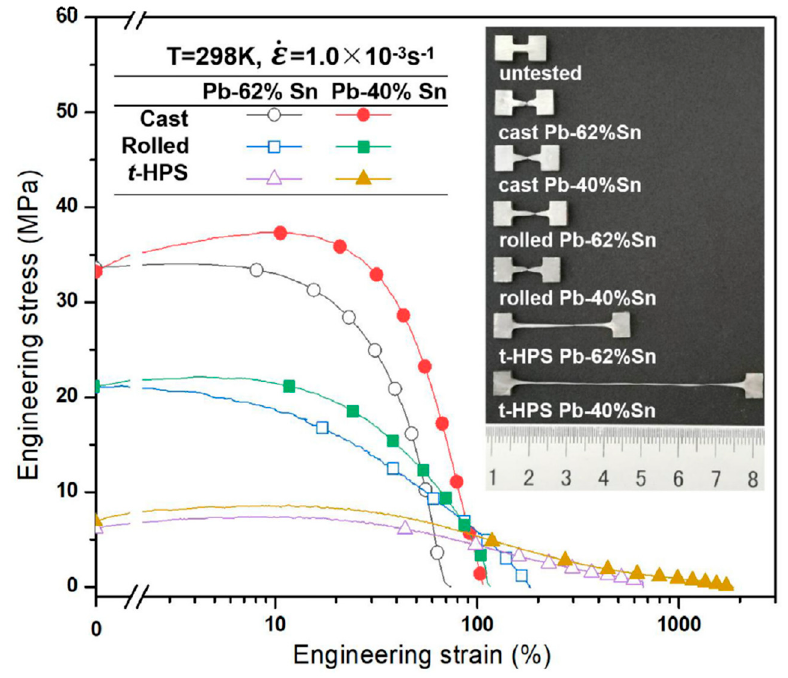
Figure 11. Examples of superplasticity in two Pb–Sn alloys processed by tube high-pressure shearing [48].